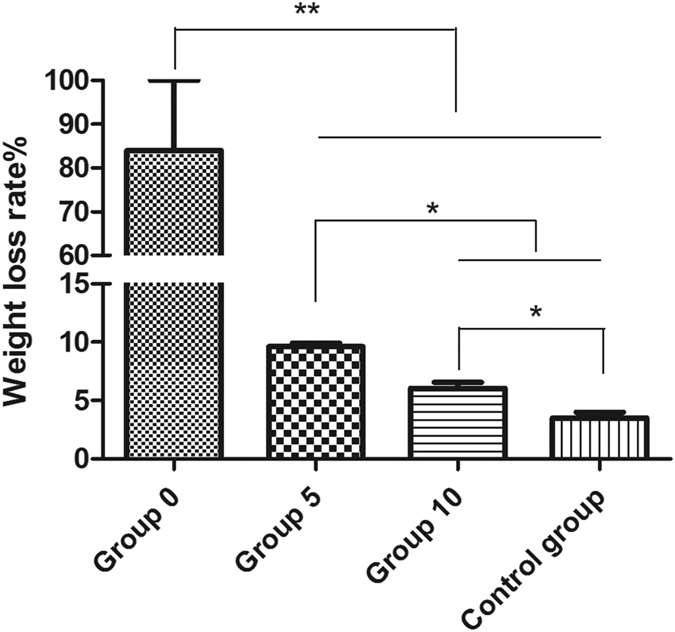
Weight loss rate of HP Mg disc.*p < 0.05; **p < 0.01.